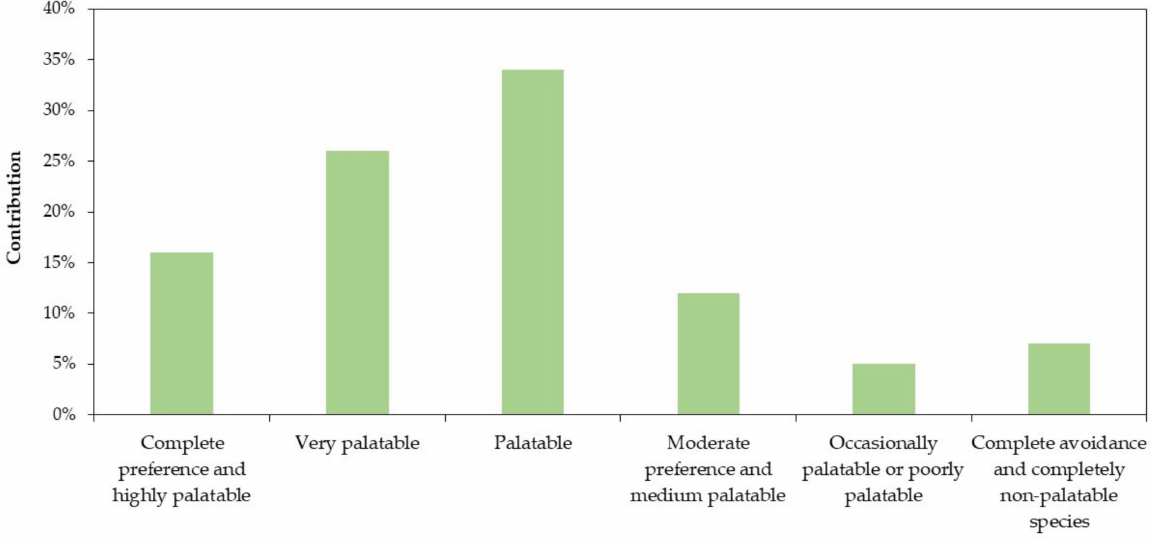
Figure 7. Palatability degree of the plant species ( n = 95) by local herders in the studied forest rangelands of Northern